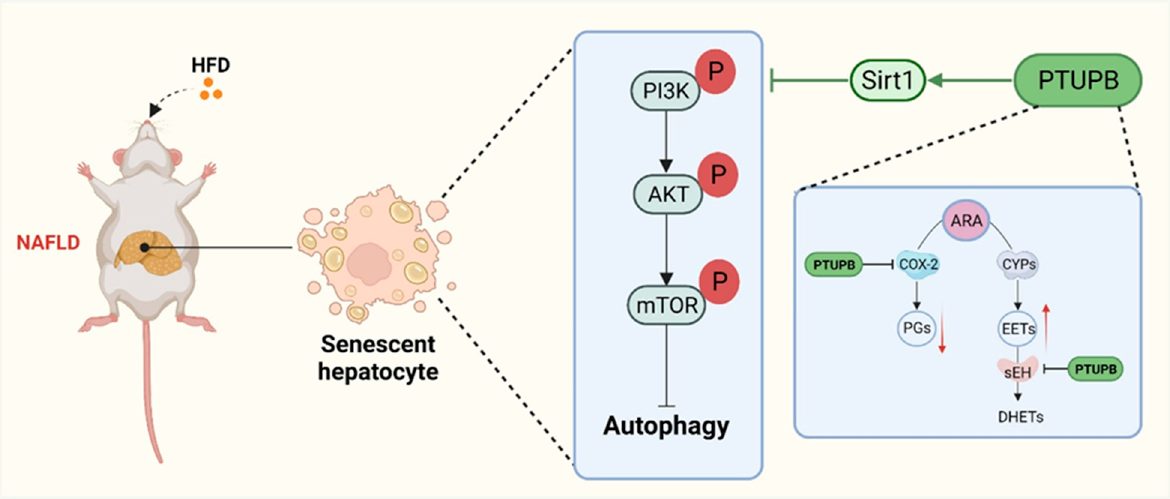
Figure 8. Schematic illustration. PTUPB alleviates HFD-induced NAFLD by reducing hepatocyte senescence through autophagy in mice. senescence through autophagy in